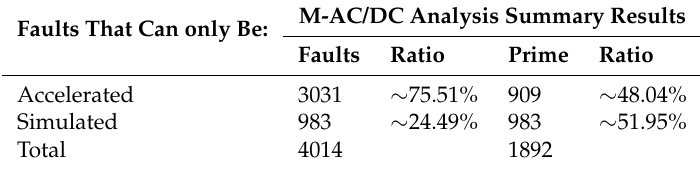
Table 4. Tick Timer (TT) fault candidates that are suitable for acceleration. Faults That Can only Be: